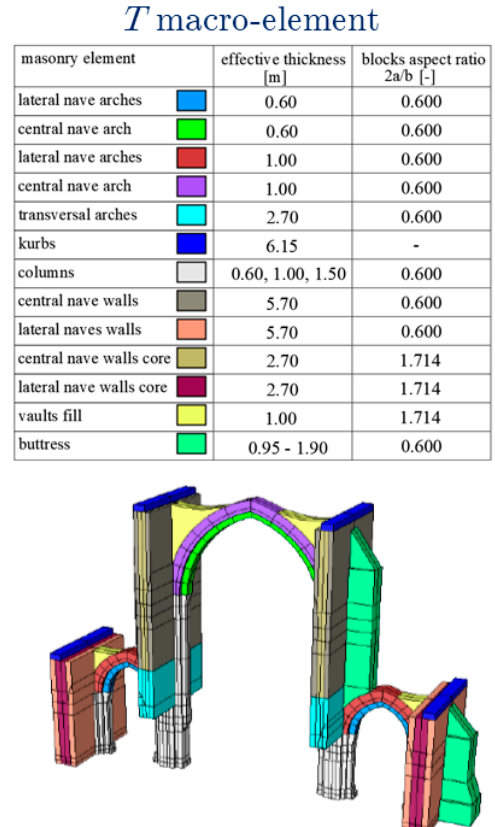
Figure 10. T macro-element.